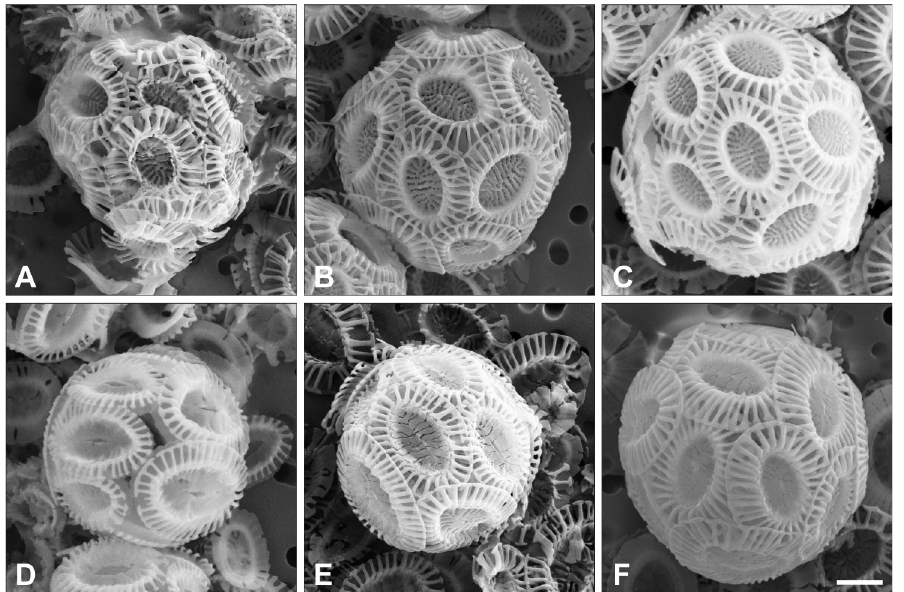
Fig 5. Representative E . huxleyi coccosphere morphology under each salinity treatment. Strain RCC1232 grown under (A) salinity 25, (B) salinity 35, and (C) salinity 45. Strain PLYB11 grown under (D) salinity 25, (E) salinity 35, and (F) salinity 45. All images are at the same scale, scale bar represents 1 μ